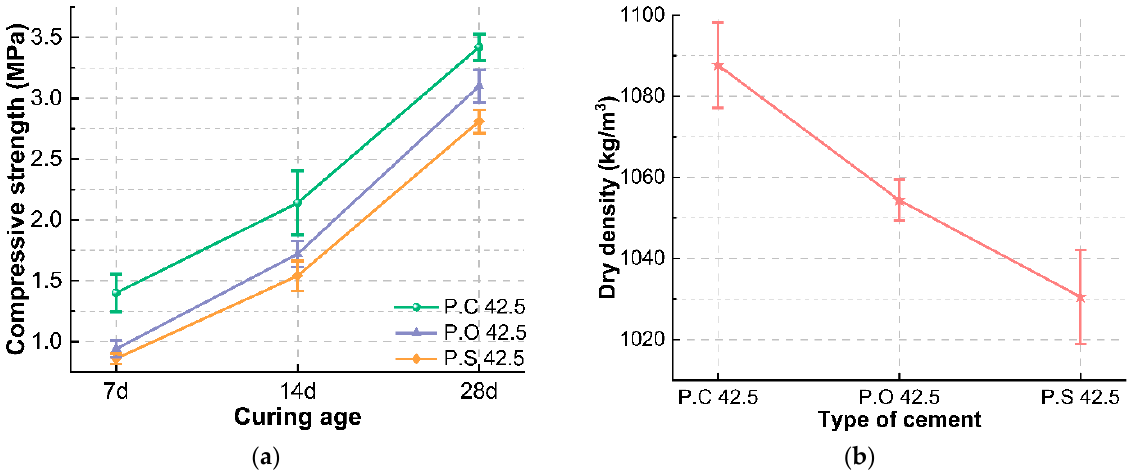
Figure 10. Effect of cement types on ( a ) compressive strength at different ages and ( b ) dry density of foam concrete.